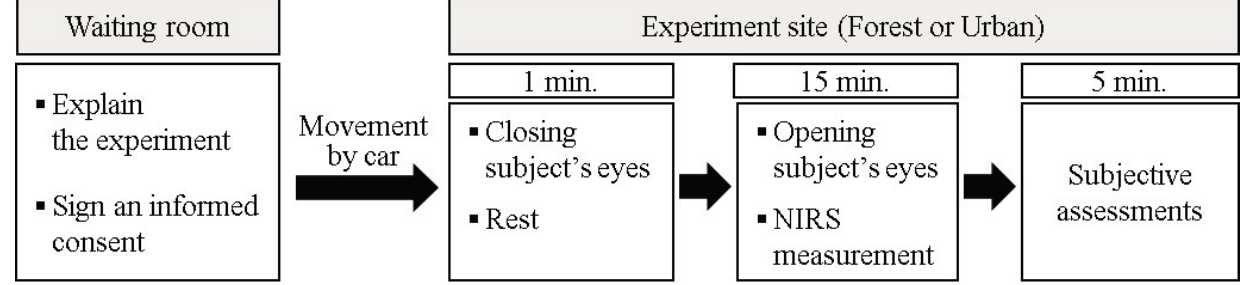
Figure 1. Experimental design.